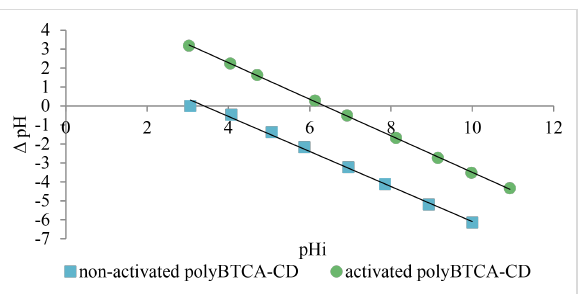
Figure 2: Determination of the PZC for the non-activated and acti- vated polyBTCA-CD polymers (pHi: initial pH value, see also Experi- mental section).